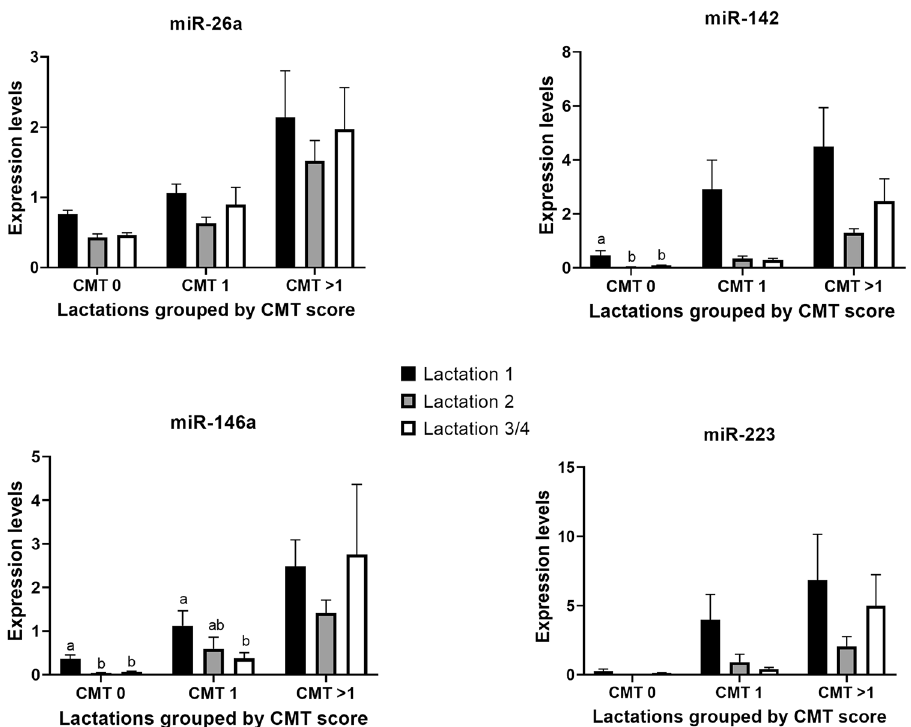
Figure 1. Relative expression levels (Mean ± SE) of bta-miR-26a, bta-miR-142, bta-miR-146a and bta-miR-223 in milk samples with CMT score 0, 1 or > 1 that were collected from individual mammary quarters of cows at different lactations (1, 2, and 3/4). An effect of lactation number was significant for miR-26, miR-142 and miR-146a ( P < 0.005), for which miRNA levels were higher during lactation 1 than during subsequent lactations ( P < 0.05). For miR-142 and miR-146a, a CMT x lactation number interaction was also detected ( P < 0.01); significant differences within CMT scores that were responsible for such interactions are indicated by different letters (a,